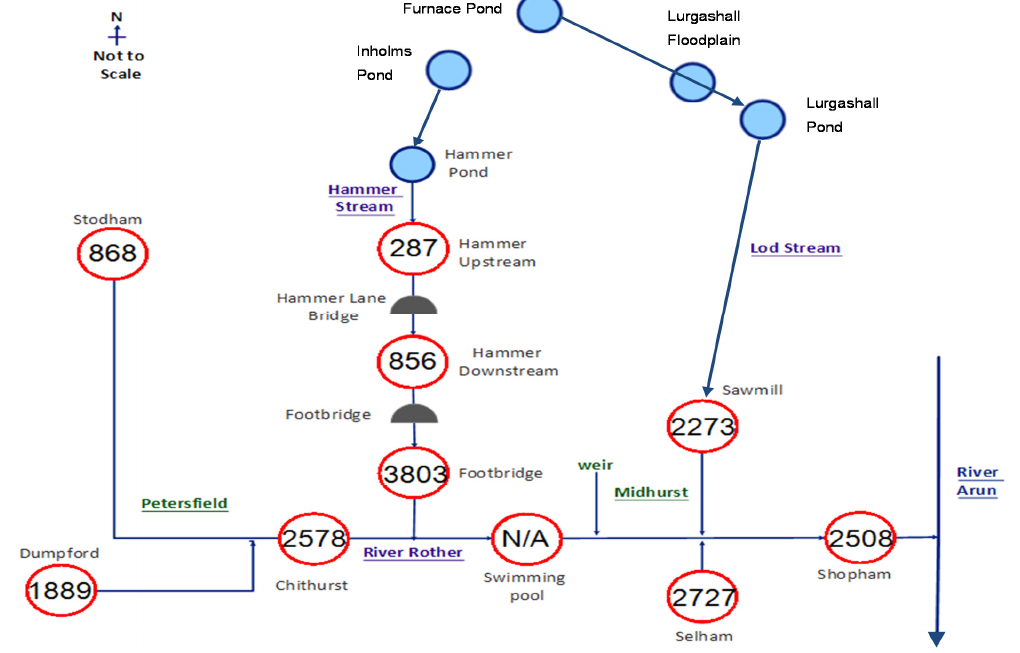
Figure 2. Locations of the monitoring sites in the Rother catchment (red circles) and coring sites (blue circles). Red circles display mean sediment storage at the monitoring sites (gm − 2